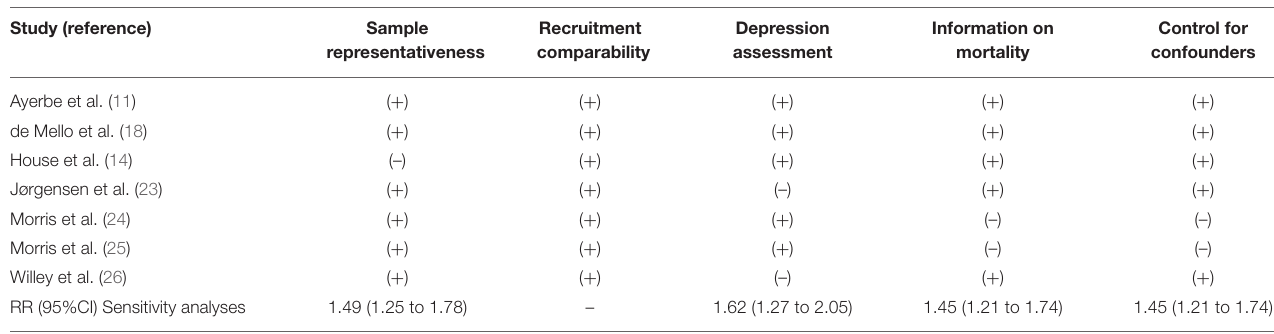
TABLE 2 | Quality assessment and sensitivity